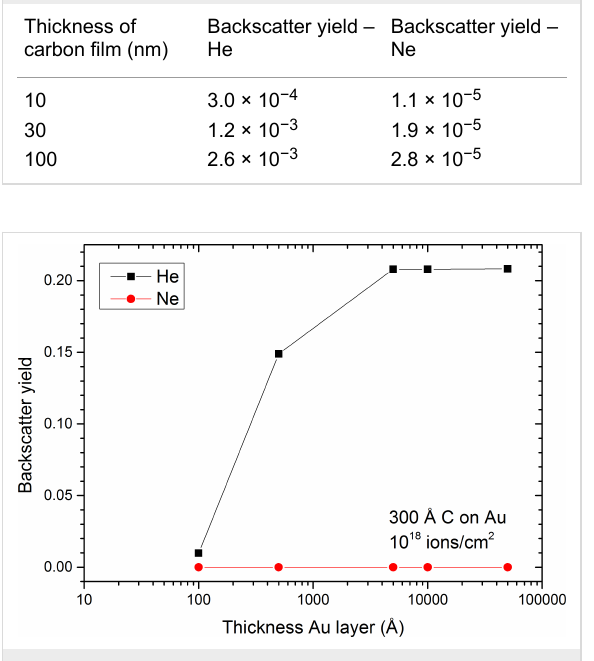
Figure 6: Backscatter yield as a function of gold thickness for He and Ne irradiation of a 30 nm carbon film deposited onto a gold grid. Results have been obtained by SDTRIMSP.